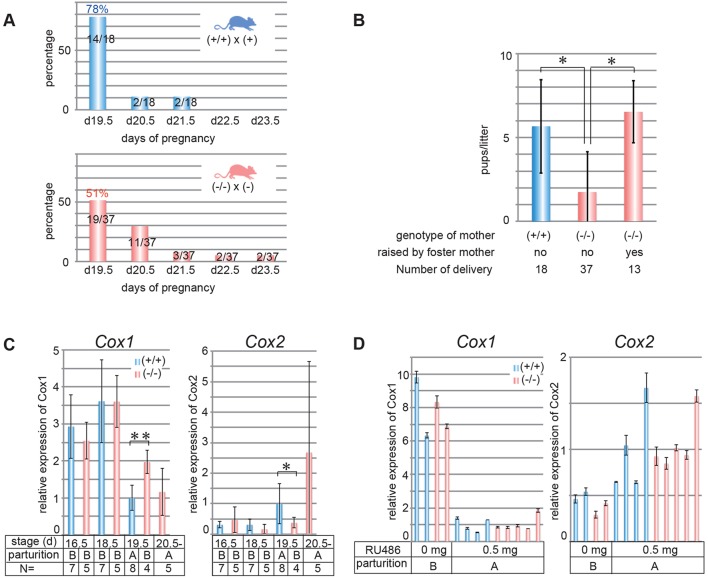
Delayed parturition in Sirh7/Ldoc1 female KOs. (A) Delayed parturition in Sirh7/Ldoc1-null mice. Delivery days of +/+ and −/− females mated with + and − males, respectively [indicated as days post coitum (d)]. (B) Decreased weaning rates. Average litter size (mean±s.d.) for +/+ females mated with + males (blue) and −/− females mated with − males (red), with or without foster mothers (postpartum females) (*P<0.05). (C,D) Expression levels of Cox1 (left) and Cox2 (right) mRNAs without (C) and with RU486 injection (D) in +/+ (blue) and −/− (red) uteri on d16.5, d18.5, d19.5 and over d20.5 (before or after parturition) are shown (data are mean±s.d., **P<0.01, *P<0.05). (A,B) Mice after (A) and before (B) parturition. The average of +/+ uteri on d19.5 was defined as 1.